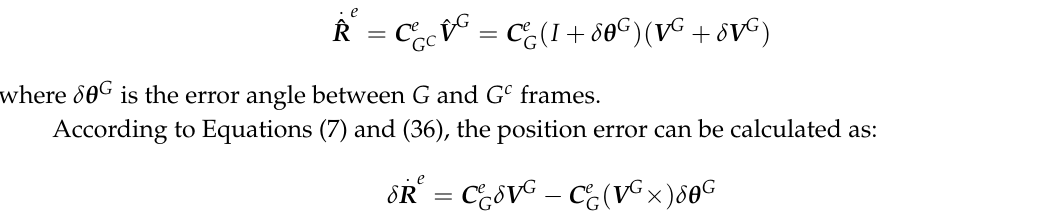
frame. The error